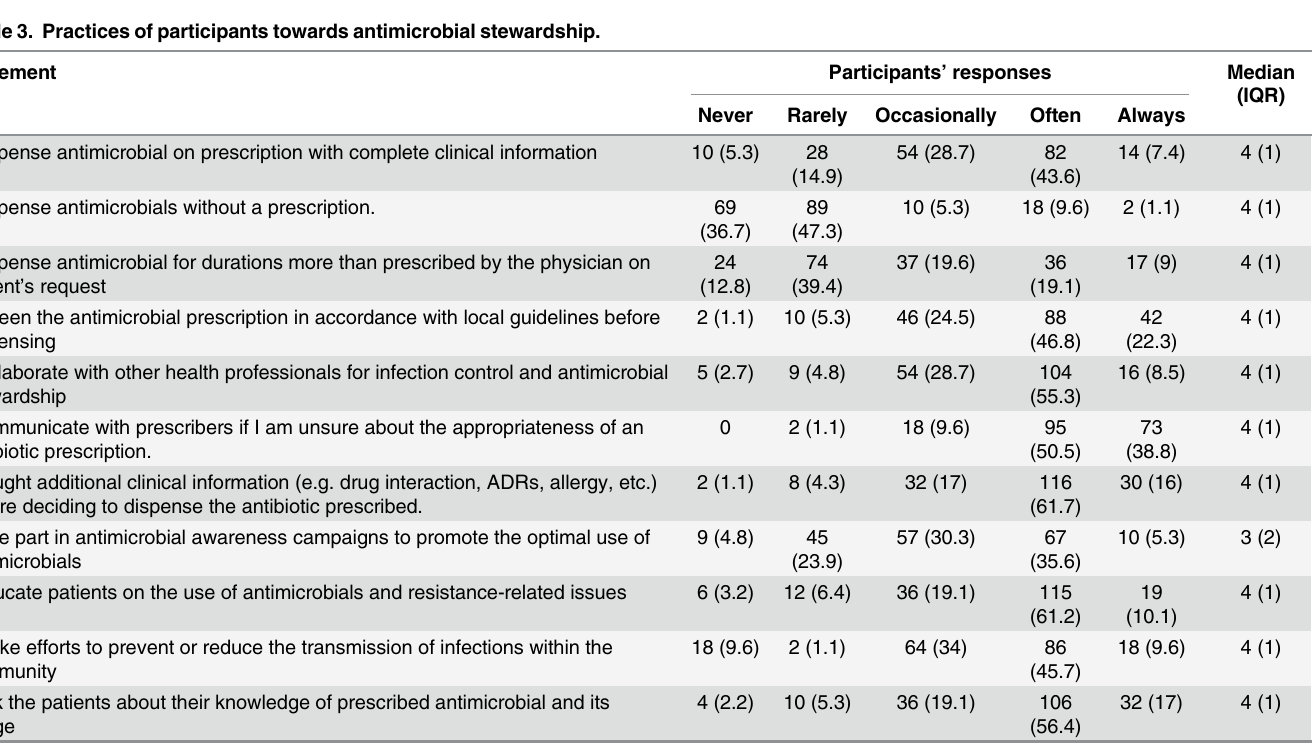
Table 3. Practices of participants towards antimicrobial